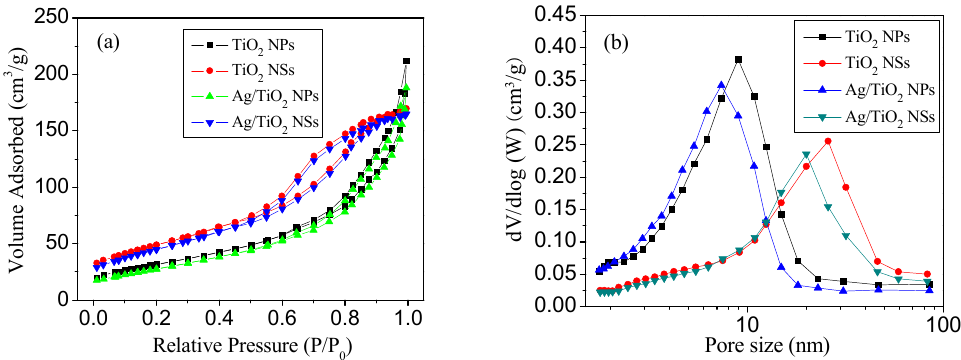
Figure 4. N 2 adsorption-desorption isotherms ( a ) and pore size distribution curves ( b ) of different catalysts.